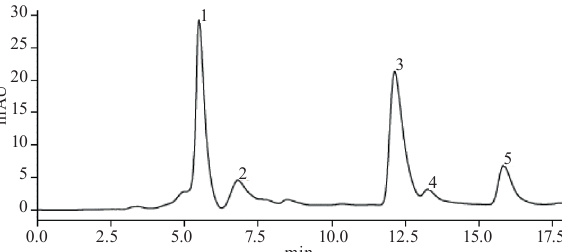
Figure 1 Chromatogram of ethanol extract from rhizomes and roots of Rhodiola rosea L.